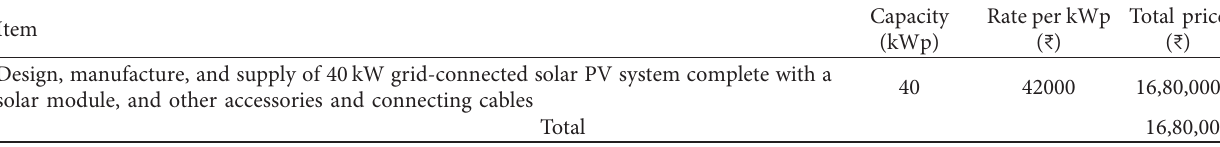
Table 12: PV system cost quotation.